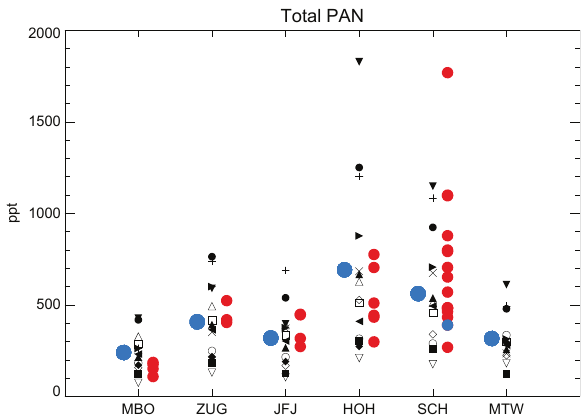
Figure 3. April mean PAN abundances (ppt) simulated (black sym- bols, one per model as defined in Table 1; blue circles offset to the left show multi-model mean values) and measured (red circles offset to the right of the model values) at northern midlatitude mountain- top sites: Mount Bachelor (MBO), Zugspitze (ZUG), Jungfraujoch (JFJ), Hohenpeissenberg (HOH), Schauinsland (SCH), and Mount Waliguan (MTW). The observed year 2001 April mean, which cor- responds to the meteorological year used by most of the models at Schauinsland, is shown in blue to the right of the